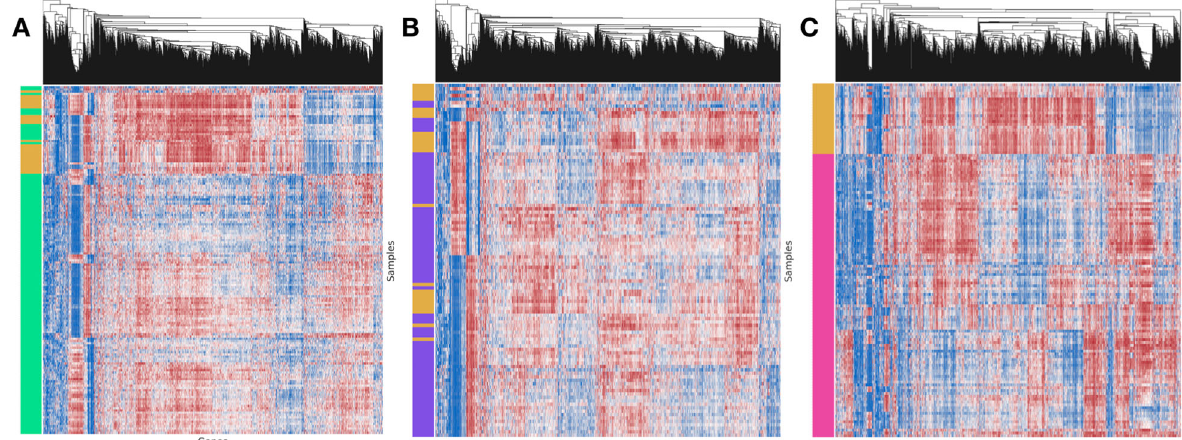
Fig. 2 Clustermap of gene-level embeddings for 2000 most variable genes in. A GBM, B LGG, and C MB. The left color track indicates the presence of the subtype; yellow indicates the presence of controls; green, purple, and pink indicate the presence of the GBM, LGG, and MB subtypes, respectively; columns have been standardized to highlight trends; in the heatmap, red indicates high MethylSPWNet embedding values, while blue indicates low embedding